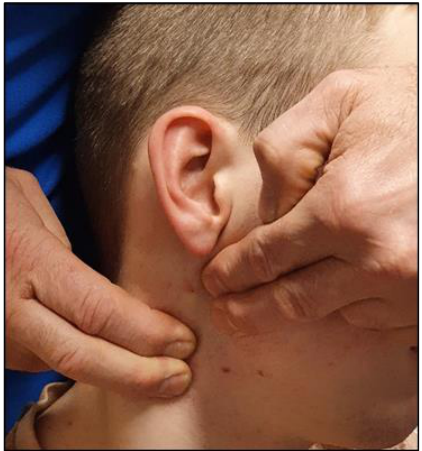
Figure 1. Examiner hand position during the atlas-axis rotational test (A-ART). While standing behind the seated patient, the examiner places both hands on the occipito-cervical junction, opposite the side of head rotation. With the 2nd and 3rd fingers, the examiner’s lower hand (right, in the photograph) is used to stabilize and traction posteriorly against the transverse process of C2. The 2nd and 3rd fingers of the other hand (left, in the photograph) contact the mastoid process of the occiput and lateral mass of the atlas, respectively. The test is then performed with varying angles of cervical rotation, to locate the position that yields maximal movement between C1 and C2, and graded by the amount of C1 versus C2 movement described in the text. For the purposes of the present study, a grade of 0 – 1 equates to little perceived relative rotational motion between the trans- verse processes of C1 and C2 (subjectively gauged, less than ~5 mm), and 2 or more exceeds this threshold. 2. Methods 2.1. Inclusion Criteria The data used for the analysis were retrospectively abstracted from medical records and imaging files for patients who had been referred by their general practitioner (GP) to a single physiotherapy and rehabilitation practice for evaluation and treatment of chronic post-traumatic neck pain (range 4 to 8 years after injury), from 2015 through 2020. The primary inclusion criteria for the study were that (1) there was a relatively high clinical suspicion of UCRI based on the clinical presentation, and (2) both the A-ART and a dy- namic rotational CT scan were performed on the patient. The clinical suspicion of UCRI was based on the presence of chronic (i.e., >6 months duration) neck pain complaints combined with symptoms potentially of a craniocervical origin, including dizziness, headache, and a sense of head pressure, including a worsen- ing of the symptoms with head rotation, including during normal activities. The provoked symptoms in some cases would persist for hours to days. The A-ART was performed on the patients by 2 blinded clinicians, and graded 0 to 3. and the patient was subsequently referred to an outpatient imaging center for a CT scan of the upper cervical spine which included a dynamic rotational stress protocol. As noted above, prior to the CT scan, all of the patients had a cervical MRI study in order to rule out significant CNS or musculoskel- etal pathology. A total of 57 patients (44 female/13 male) were identified for study, after the exclusion of one patient with a suspected connective tissue disorder. For the purposes of the study, most accurately described as a prospective cohort design, patients were dichotomized into 2 groups by A-ART grade, following the same protocol described by Kaale et al. [6], in which a result of 2 –3 was deemed “abnormal” or positive for UCRI (little to no stop feeling of C1 lateral mass at the end of rotation), and 0 –1 was deemed “normal” and negative for UCRI (solid or soft stop feeling during rotation). See Figure 1. Two physiotherapist exam- iners, both experienced with application of the A-ART, had to agree that the A-ART grade was 2 or 3 for the patient to be categorized in the “abnormal” group. As these data were